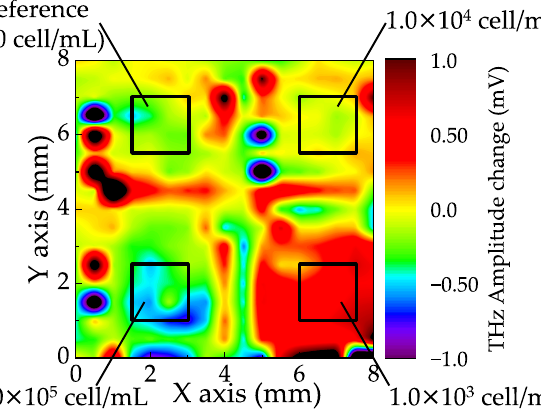
Figure 5. Distribution of the change in terahertz amplitude on the sensing plate as shown by the black rectangles in Figure 4a between before and after the reaction of PC9.